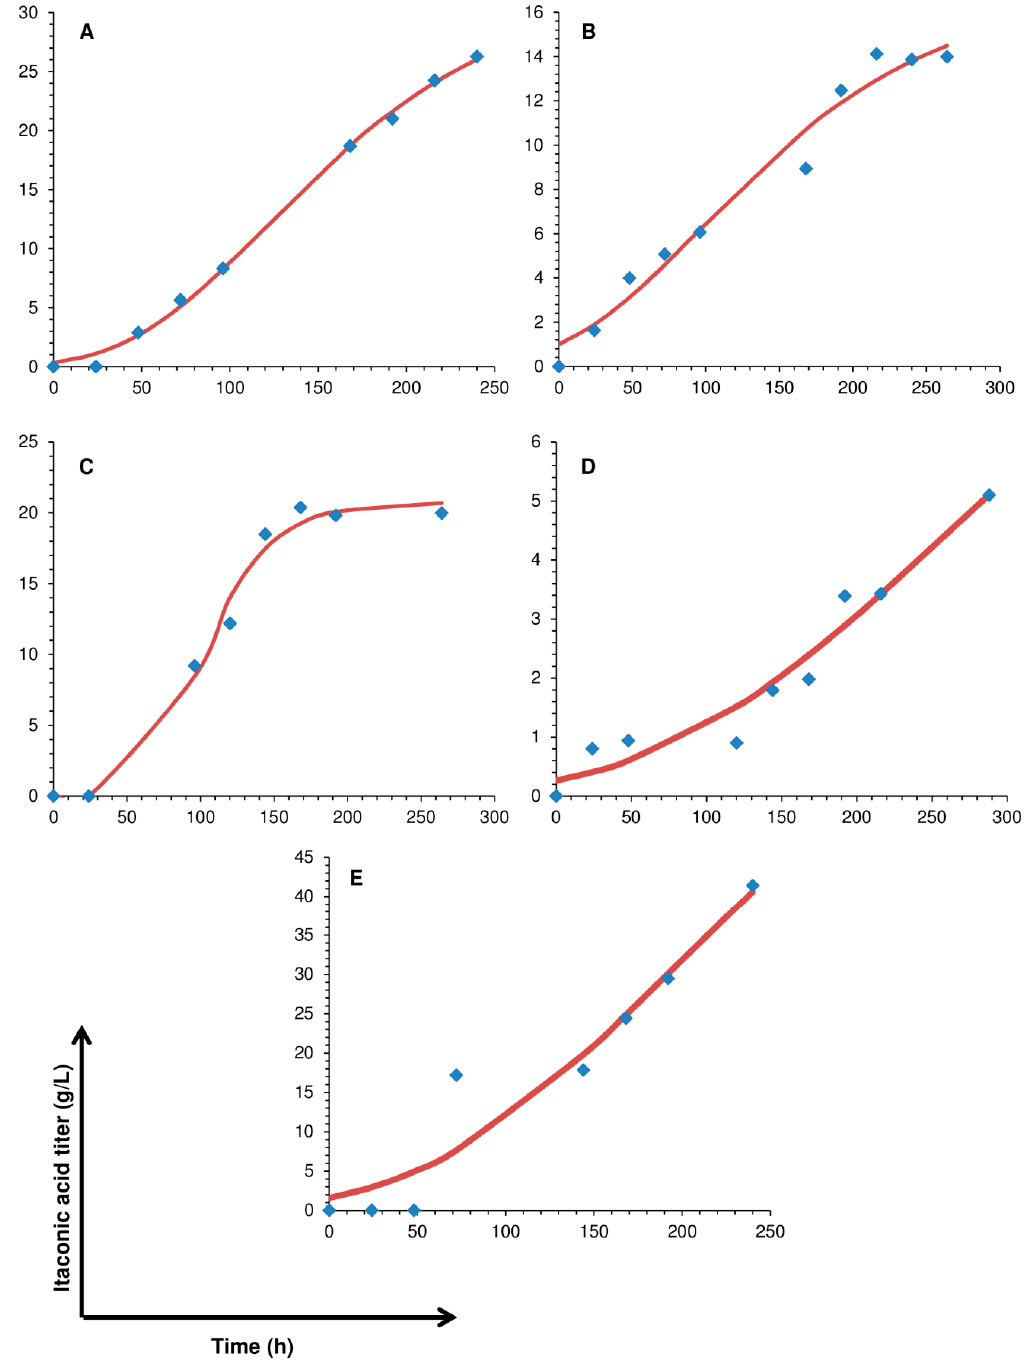
Figure 1. The time profiles of itaconic acid production experiments. Notations ( A – E ) are as explained in Table 1. Blue diamonds: Measured data (Table 2); Red lines: Fitted curves derived from the modified Gompertz-model in Equation (1).